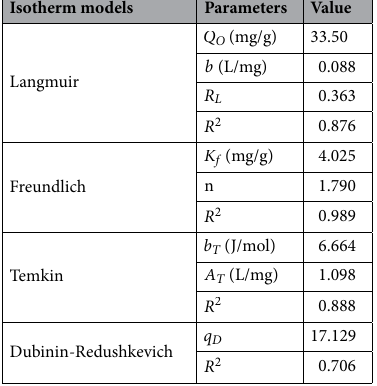
Table 2. Isotherm models parameter of CR adsorption onto GSC WCO